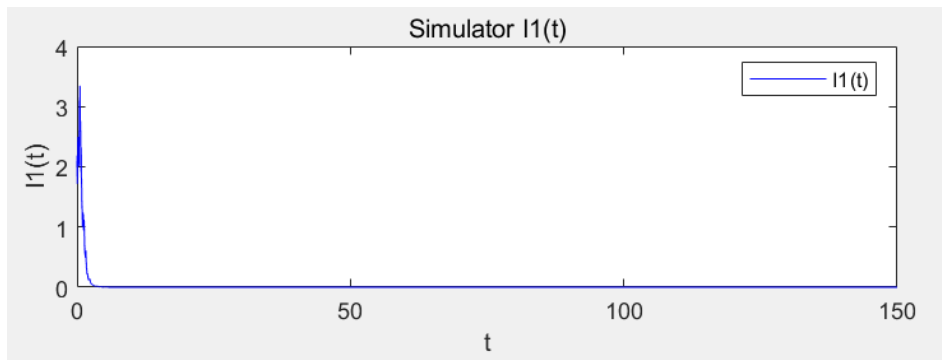
Figure 12. Sample path of I1(t).